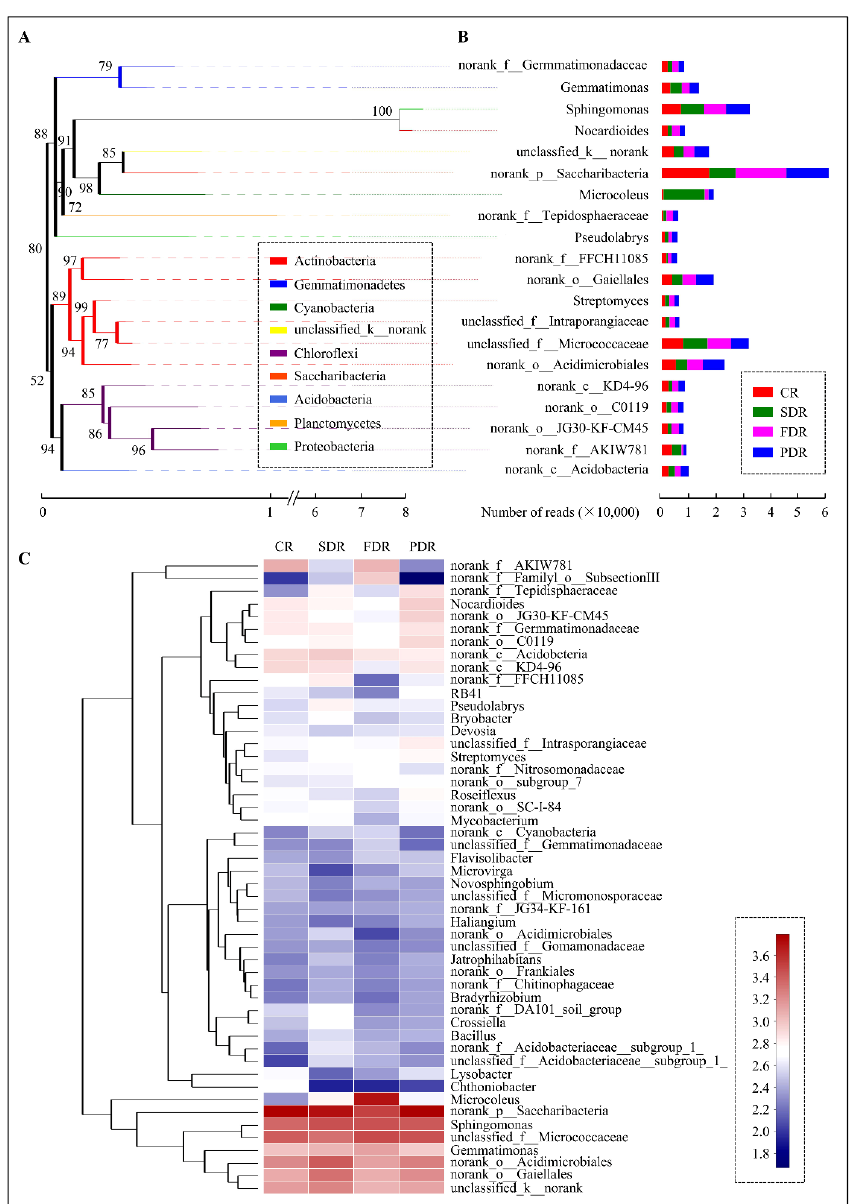
Figure 5. Taxonomic analysis through phylogenetic tree and heat map. ( A ) A phylogenetic tree showing the relationship among drought-treated and untreated soil groups. The phylogenetic tree was constructed on the basis of 16S rRNA gene sequences. Bootstrap values were obtained from a search with 1000 replicates and are shown at the nodes. Species names and proportions in four soil groups showing in the right. ( B ) The heat map visualization with hierarchical clustering of the top 50 most abundant genera was generated according to the similarity among their constituents, and were arranged in a horizontal order according to the clustering results. ( C ) In the figure, red represents the more abundant genera in the corresponding soil group, and blue represents the less abundant genera. The names of “norank” and “unidentified” are all unidentified species obtained directly from database via sequence alignment.